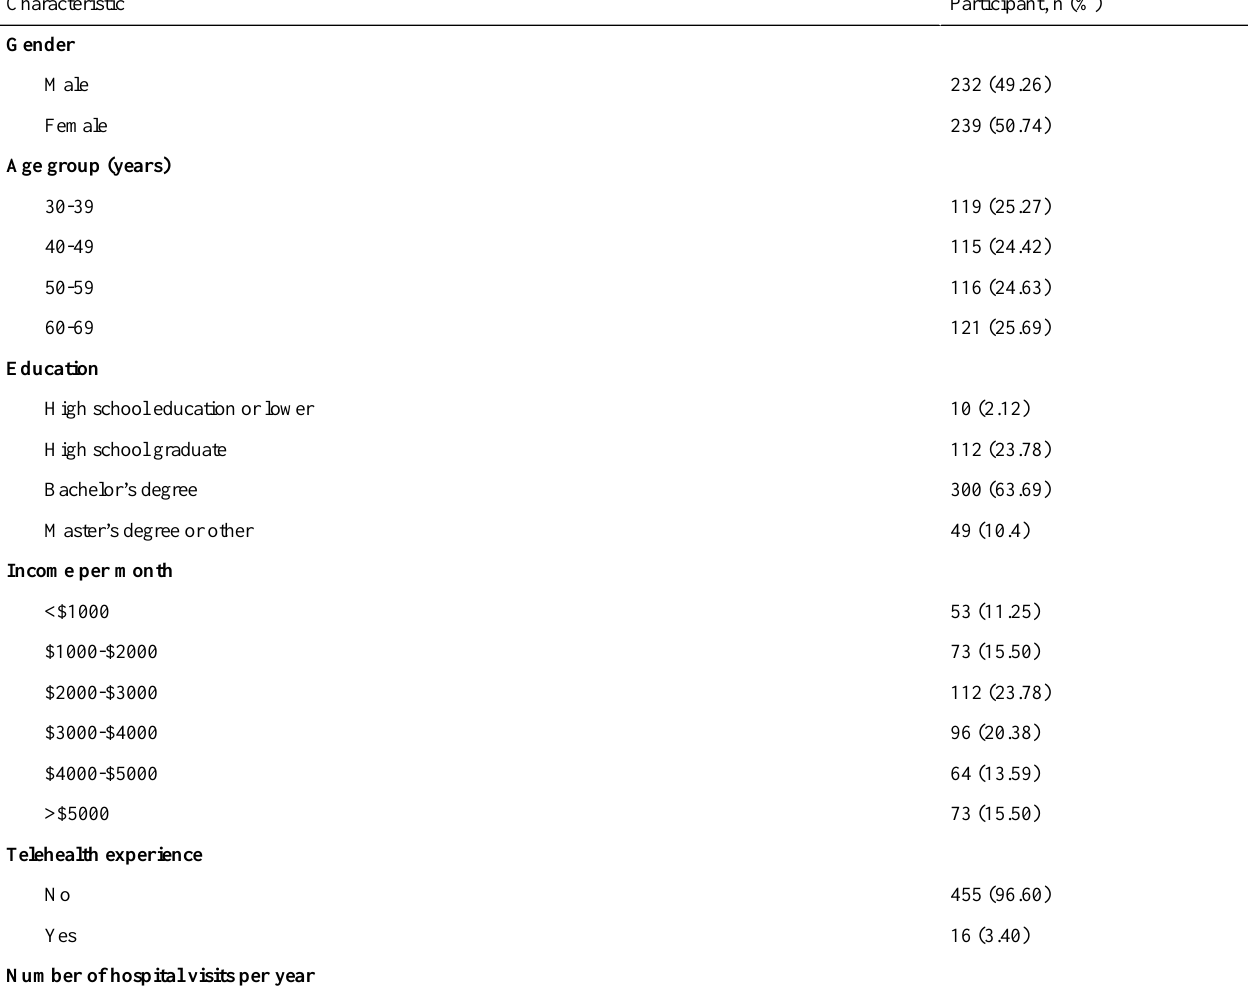
Table 2. Demographics of respondents